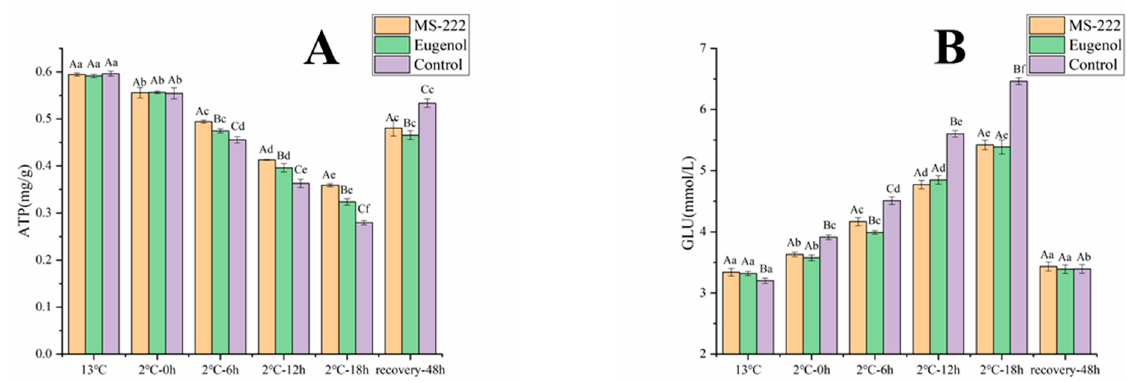
Figure 2. ATP ( A ) and blood glucose ( B ) changes in turbot affected by low-temperature transport stress. Different capital letters indicate significant differences in means between different treatment groups. Different lowercase letters indicate significant differences in means between the same treatment groups ( p < 0.05).